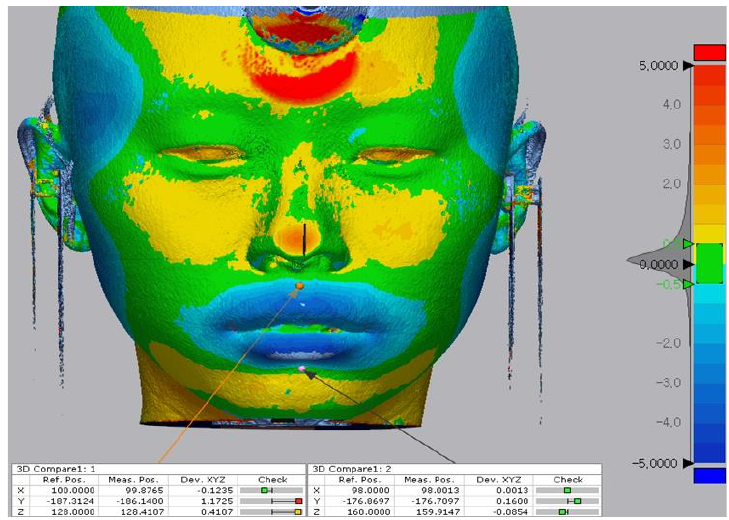
Figure 6. Comparison of reference points (pre) and measure points (post) located on the soft-tissue